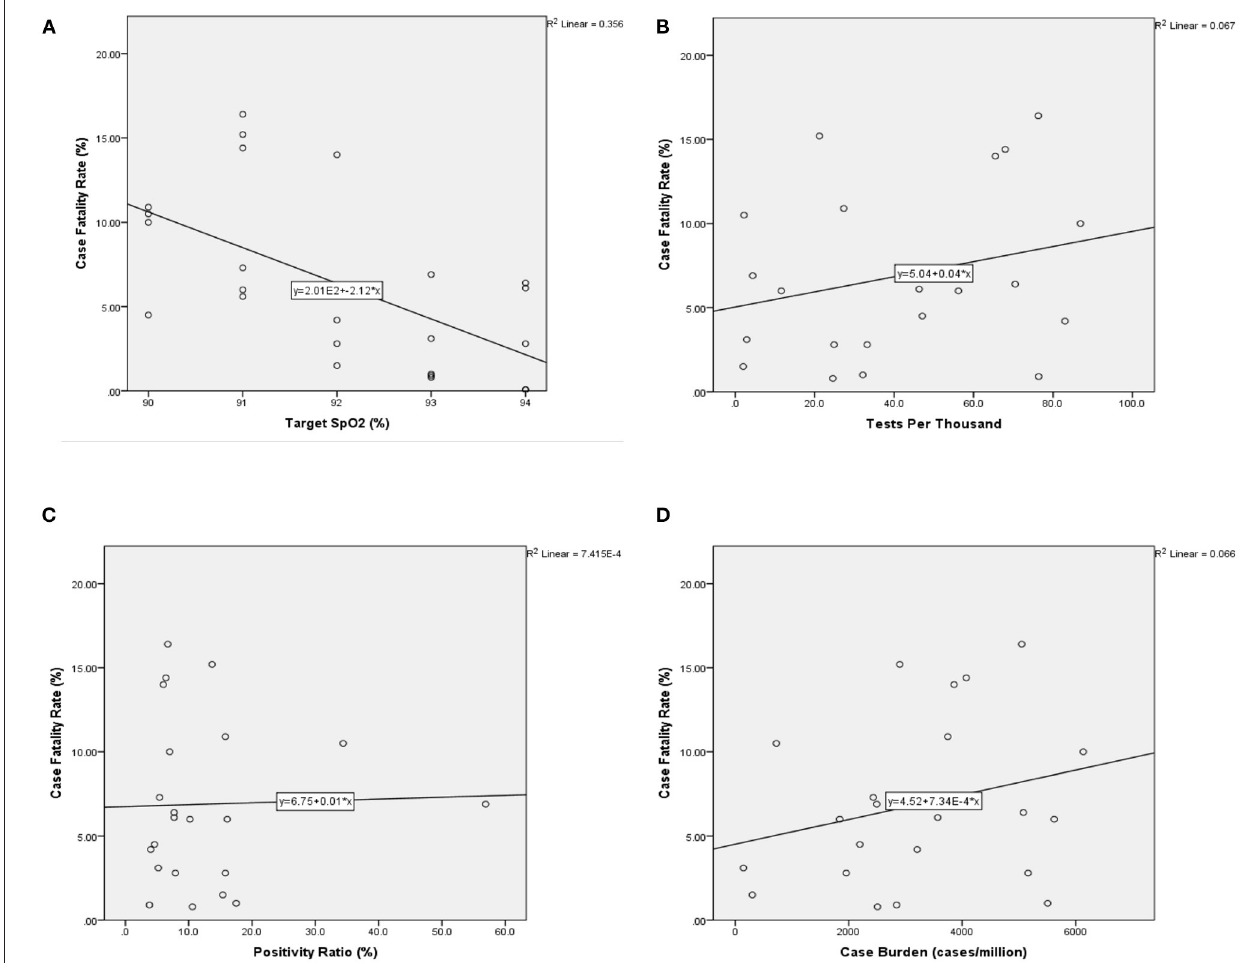
FIGURE 3 | Scatter graphs with best-fit line for primary measure and confounders vs. CFR ( N = 26). CFR is along the vertical axis in each and measured as percentage ratio. (A) Comparison of national CFR vs. nationally recommended target SpO2 (%) in COVID-19. (B) CFR vs. burden of cases measured by total number of cases per million inhabitants. (C) CFR vs. Testing Rate measured by total number of tests undertaken per thousand inhabitants (tests/thousand). (D) CFR vs. the overall positivity ratio (%), measured as the percentage ratio of positive tests to total tests. CFR, case fatality rate; SpO 2 , oxygen saturations. CFR, case fatality rate; SpO 2 , oxygen